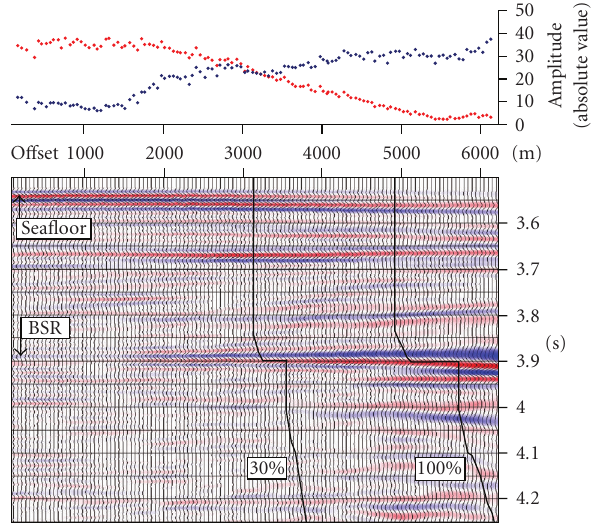
Figure 4: CMP gather 5690 is an example for the AVO e ff ect of the BSR. The black lines indicate the cuto ff s for NMO stretch mute values of 30% and 100%. A late cuto ff (NMO stretch mute 100%) includes far o ff sets and therefore stronger BSR amplitudes after CMP stacking. The upper box shows the absolute values of the amplitudes for the seafloor reflection (red dots) and for the BSR (blue